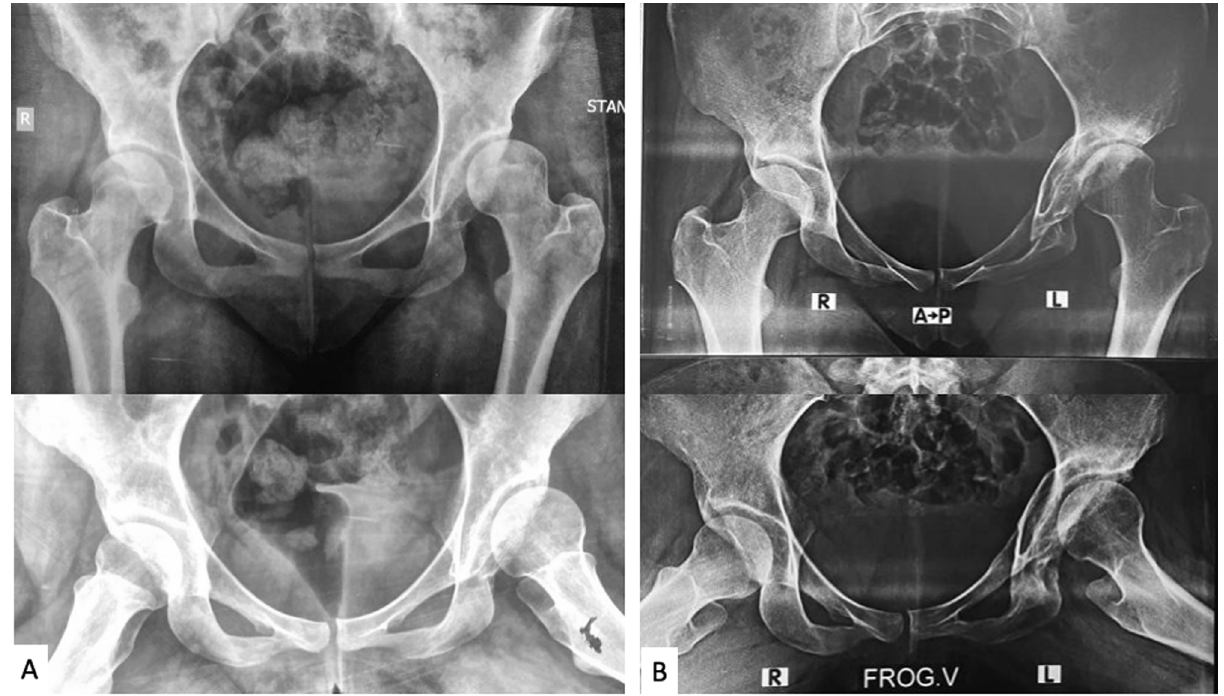
Figure 5. (A) Preoperative anteroposterior (AP) and frog-lateral radiographs of a 16-year-old female with left acetabular dysplasia. (B) 5-year postoperative radiograph demonstrating union of all osteotomies, maintained lateral acetabular coverage with a horizontal acetabular sourcil.